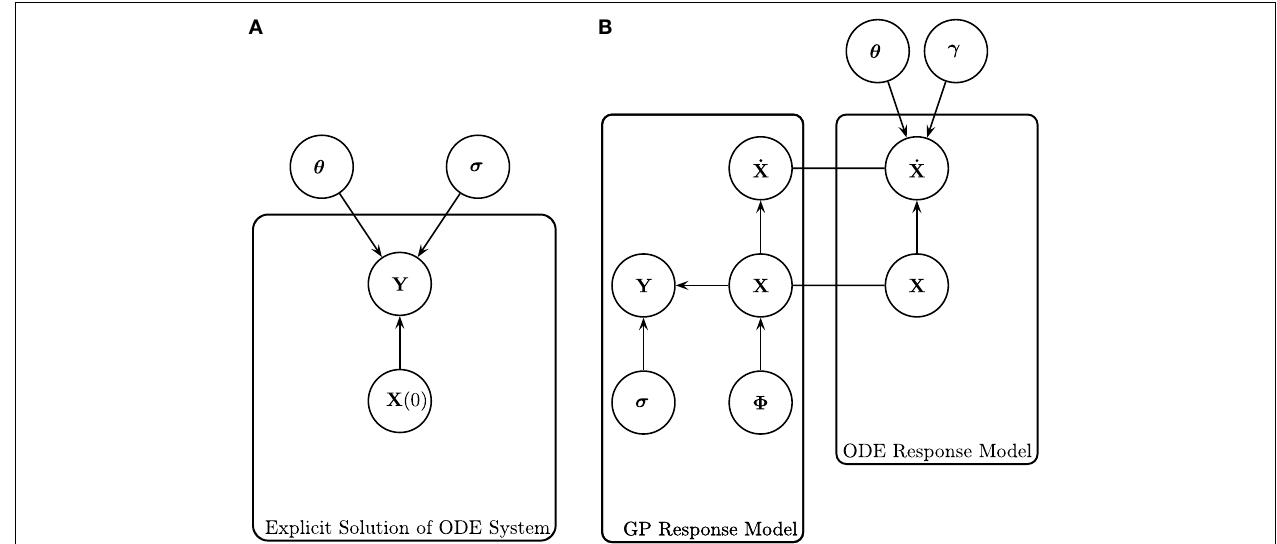
FIGURE 1 | Graphical representations of (left) the explicit solution of the ODE system, as shown in Calderhead et al. (2008), and (right) gradient matching with Gaussian processes, as proposed in Calderhead et al. (2008) and Dondelinger et al. (2013) . (A) Explicit solution of the ODE system, as shown in Calderhead et al. (2008). The noisy data signals Y are described by some initial concentration X (0), ODE parameters (cid:18) and observational errors with SD (cid:27) . For a given set of initial concentrations X (0) and set of ODE parameters (cid:18) , the ODEs can be integrated to produce a signal, which is then compared to the data signal by some metric defined by the chosen noise model. (B) Gradient matching with Gaussian processes, as proposed in Calderhead et al. (2008) and Dondelinger et al. (2013). The gradients _ X are compared from two modeling approaches; the Gaussian process model and the ODEs themselves. The distribution of Y is given in equation (4), the Gaussian process on X defined in equation (5), the derivatives of the Gaussian process _ X in equation (10), the ODE model in equation (2), and the gradient matching in equation (17). All symbols are detailed in Section 2.1.